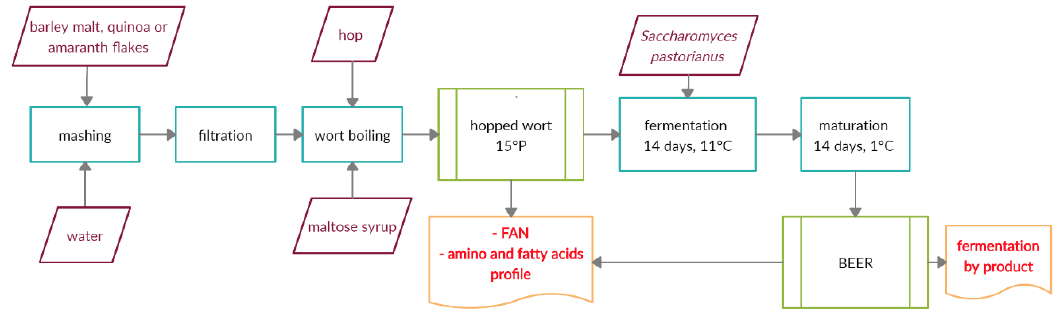
Figure 1. Scheme of wort and beer production with the conducted analyses during the research.